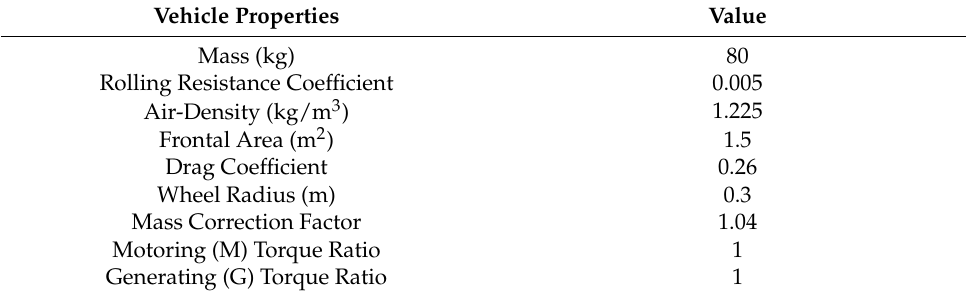
Table 4. Drive-Cycle Properties.